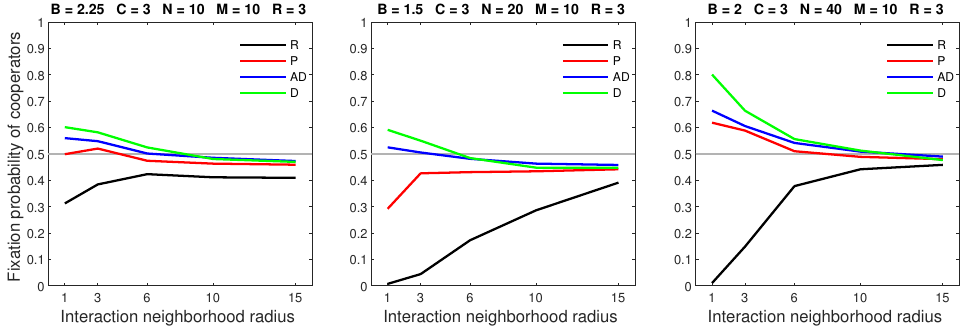
Figure 21. The deterministic dispersal is the only model that maintains a cooperator’s advantage in dense